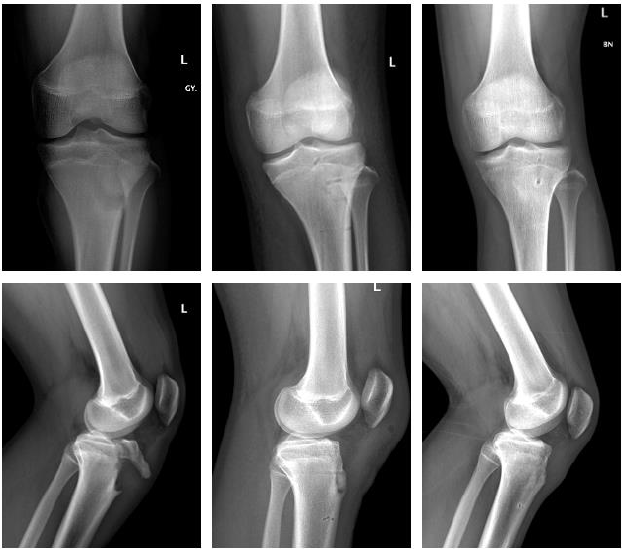
Figure 2. Fracture of tibial tuberosity with ActivaScrew™: preop, 2 days postop, 6 months postop (left to right).